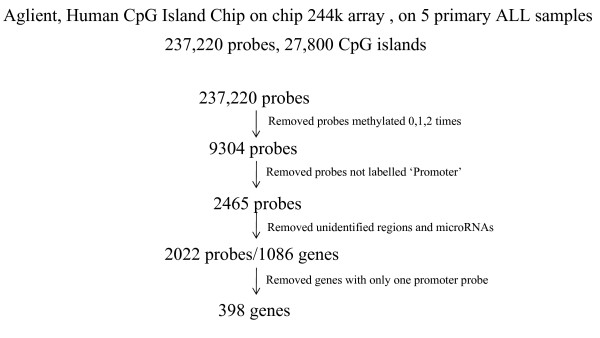
Candidate gene selection. This schematic details the criteria used in the microarray data analysis for the selection of the short list of 398 genes. The short list, only contains genes which had two or more probes labelled as 'promoter' which were methyled in at least three of the five primary samples analysed, this list does not contain any microRNAs or unidentified genes/chromosomal regions.